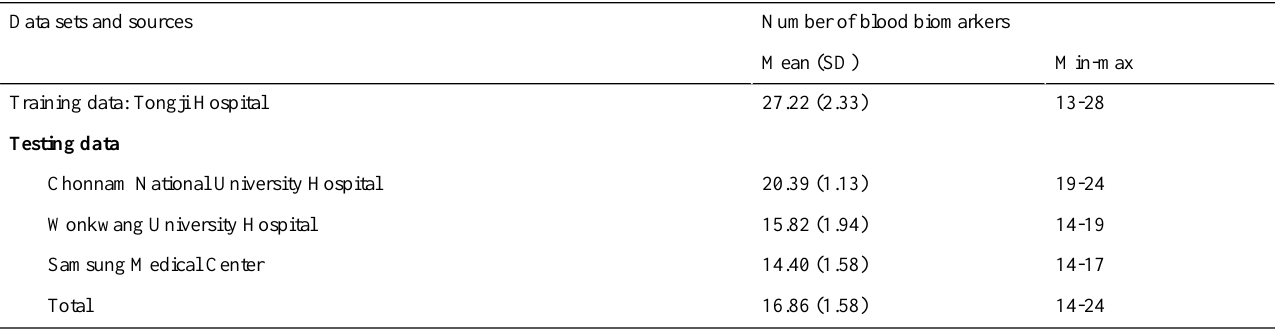
Table 3. Number of available blood biomarkers per patient for the artificial intelligence model training.